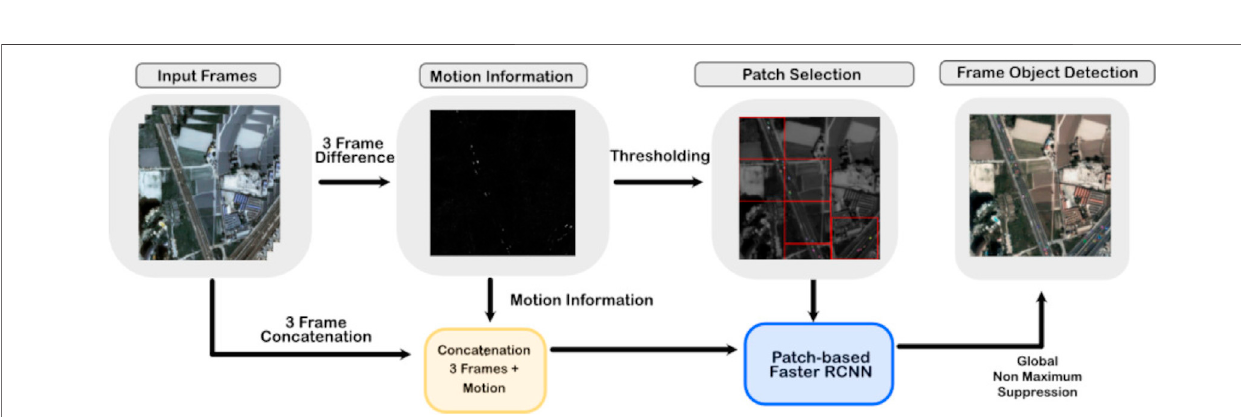
FIGURE2| Modi fi edinputforFasterRCNNtoincorporatemotioninformation. (A) Sampleinputpatchsequence. (B) Grayscale3frameconcatenation. (C) Patch3 frame difference response. (D) Concatenation of (C) and (B) . (E) Sample object detector output.